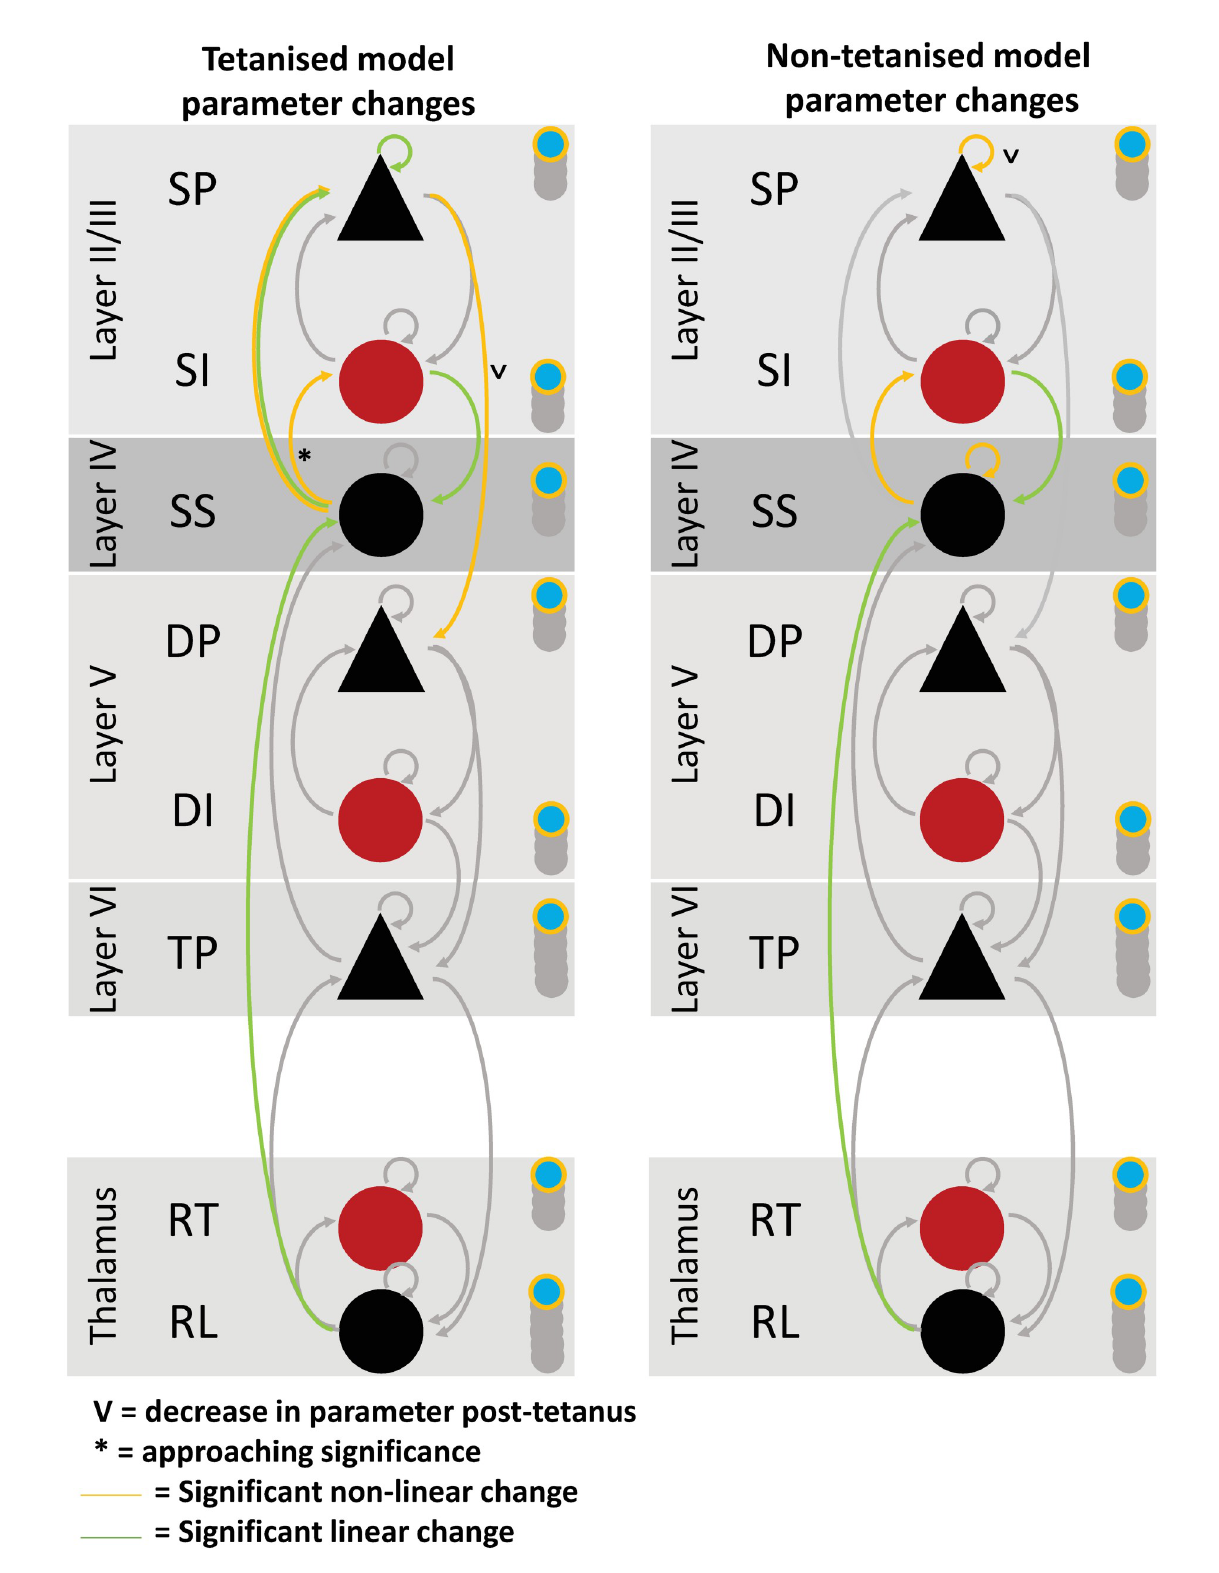
Fig 7. Difference in significant parameter changes for the tetanised compared to non-tetanised model. Note. Tetanised model results are identical to depiction in Fig 6 and are provided here for side-by-side comparison. See Fig 2C for key of parameters. https://doi.org/10.1371/journal.pcbi.1008414.g007 PLOS Computational Biology | https://doi.org/10.1371/journal.pcbi.1008414 January21,